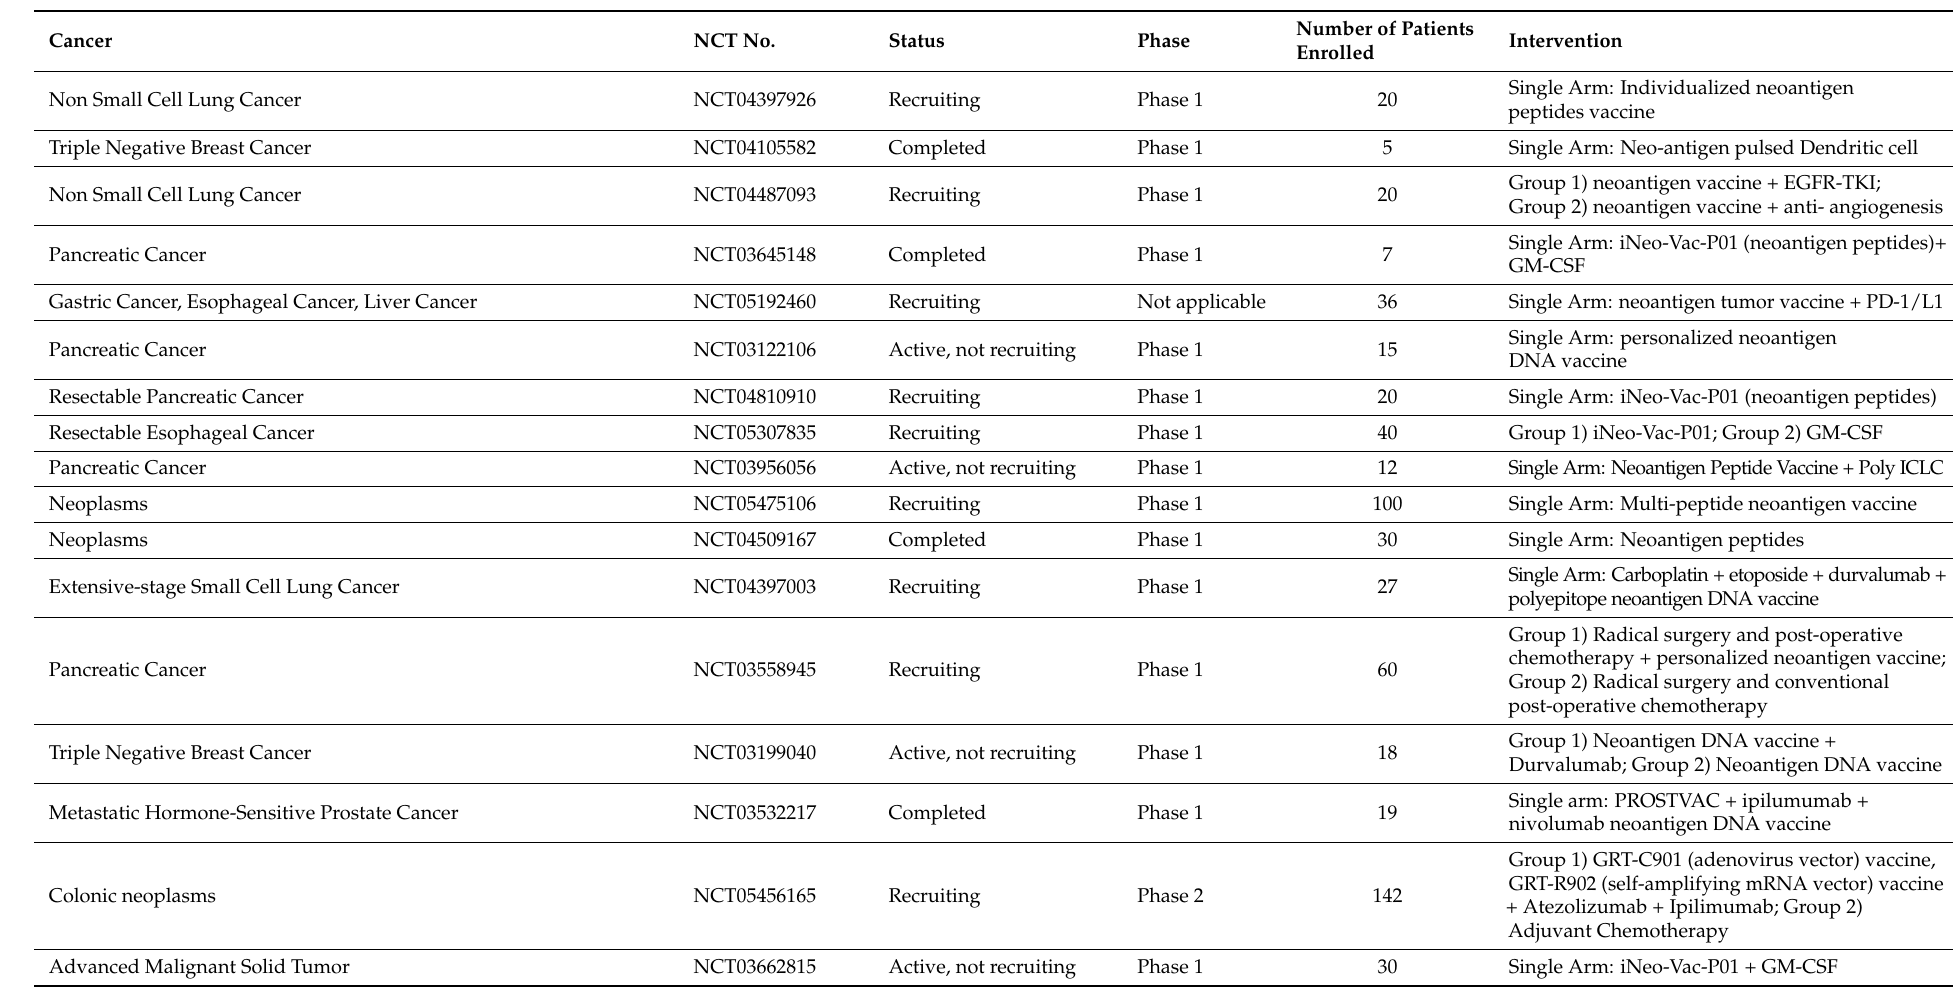
Table 3. Clinical Trials with Neoantigen